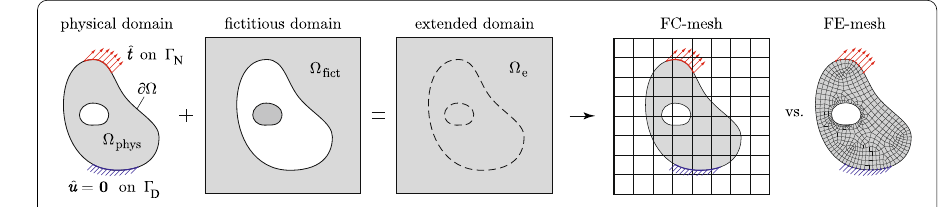
Fig. 5 Concept of the FCM including a typical discretization based on a Cartesian mesh. A comparable FE discretization is depicted on the